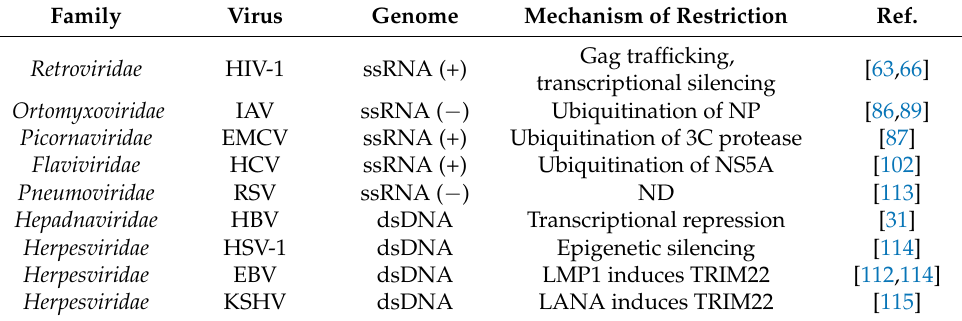
Table 1. TRIM22 restriction of RNA and DNA